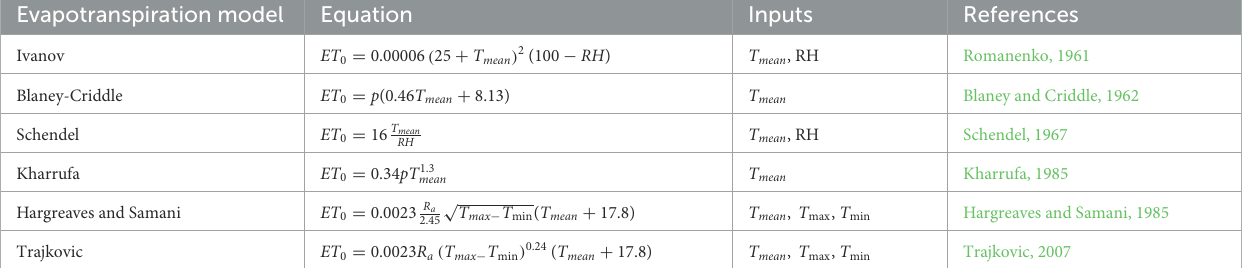
TABLE 1 Temperature-based ET 0